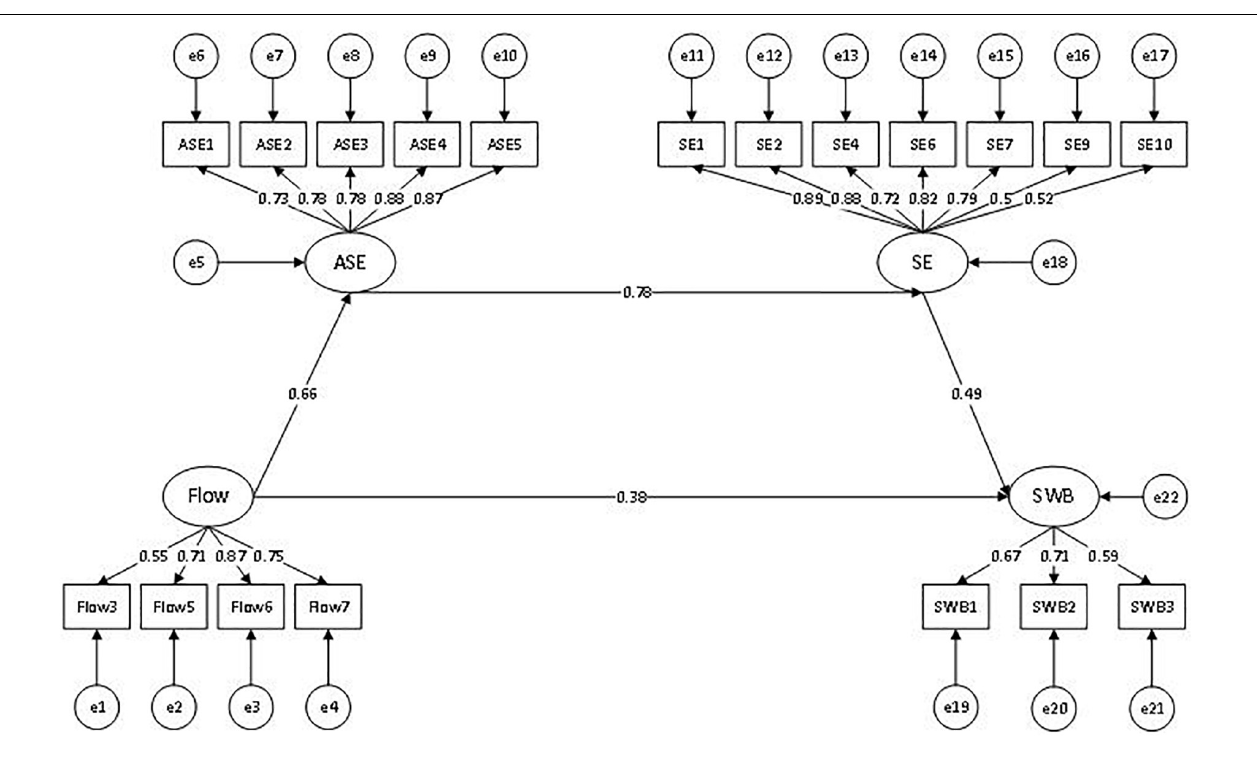
FIGURE 3 | Adjusted structural equation model. TABLE 5 | Standardized indirect and direct effects and 95%